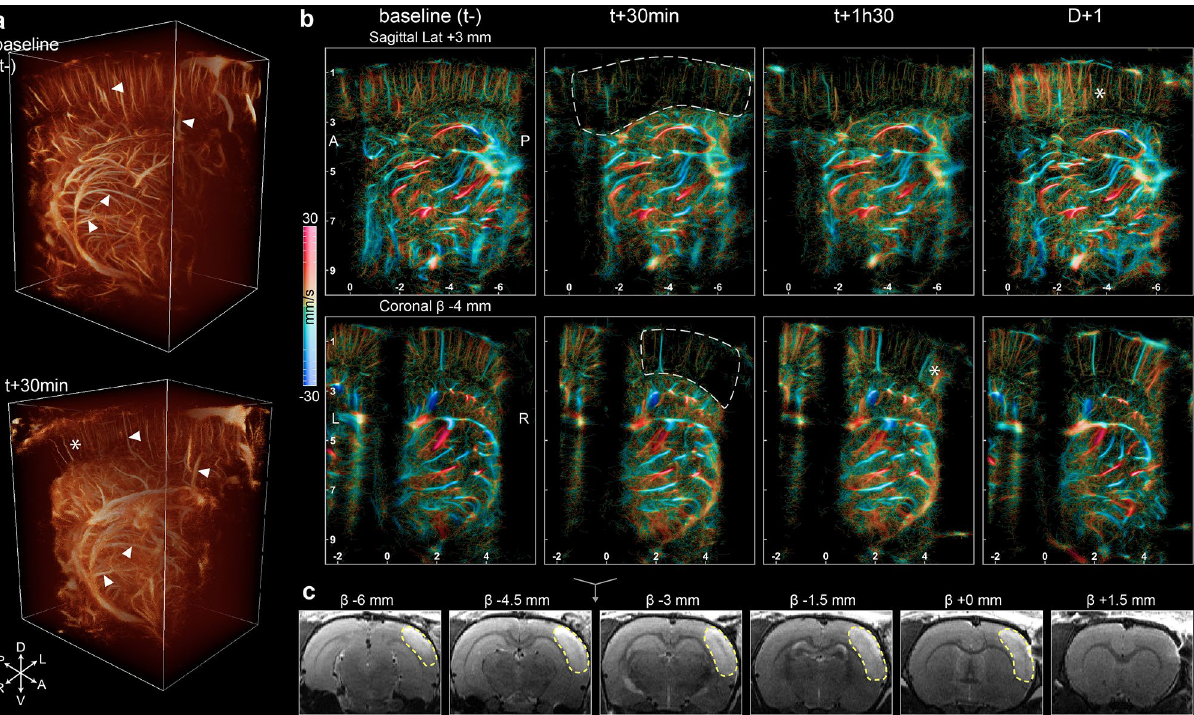
Figure 3. The MCA occlusion ischemic stroke was observed with 3DULM at the early phase. (a) 3D renderings at before and 30 min after stroke’s induction (Supplementary Video S1). ( b) Sagittal and coronal slices of 600 µm with velocity rendering at different timepoints. Ischemic cortex wrapped with a white dotted line. V max = 30mm / s . Upward flows: red, downward flows: blue. ( c) T2 MRI at D + 1 with the segmentation of the lesion (yellow dotted lines). Scale bar: 2 mm. Figures were created with ( a ) Amira 2019.4 (https:// www. therm ofish er. com/ amira- avizo), ( b , c ) MatLab 2019a (https:// www. mathw orks. com/ produ cts/